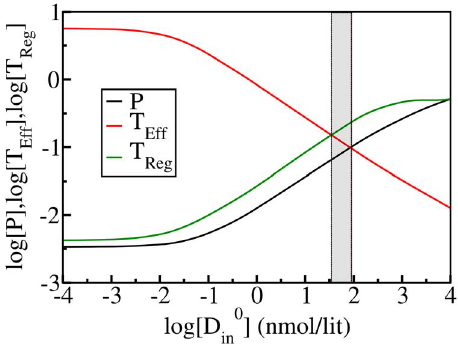
Figure 5. Steady state value analyses as a function of log (initial vitamin-D level). Evaluation of steady state regulation in terms of pathogen [P], effector T-cell [T Eff ], and regulatory T-cell [T Reg ] concentrations at different initial intake of vitamin-D. Around the vitamin-D concentration value of 50 nmol/lit, T Eff concentration falls below the concentration value of T Reg to establish a strong regulation that is necessary for the prevention of autoimmune diseases. The steady state value of pathogens starts increasing even exceeding the value of T Eff beyond [D in0 ] =100 nmol/lit. We indicate (with a gray limit bar) the optimal vitamin-D range from 50 to 100 nmol/lit where both pathogen and effector T-cell level remain at reasonably low value. Vitamin-D level beyond 100 nmol/lit corresponds to an alarming concentration compared to the standard vitamin-D limit.